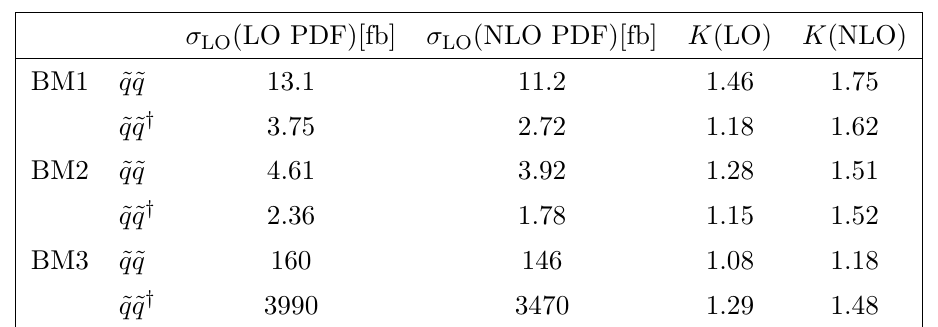
Table 3. LO cross section and corresponding K factors for the benchmark points of table 2 using PDF sets of LO and